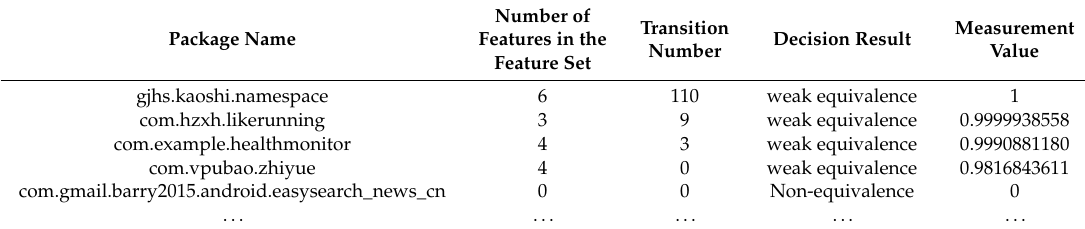
Table 12. Part of the measurement values.